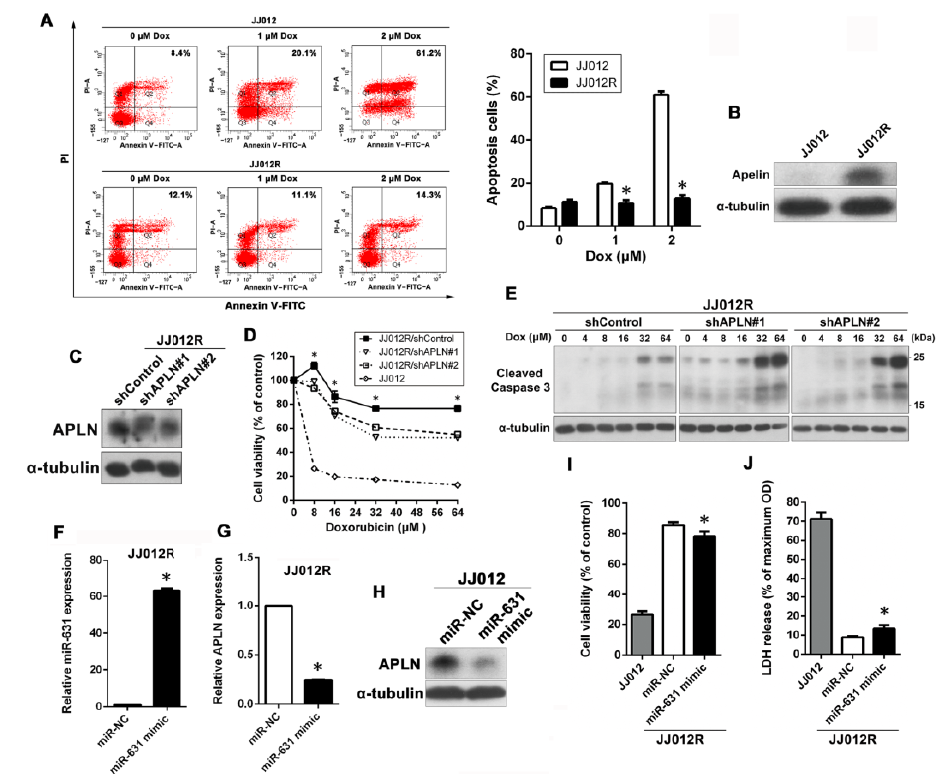
Figure 4. miR-631–APLN axis was also involved in Dox sensitivity in JJ012 cells. ( A ) Cells were exposed to increasing doses of Dox (0–2 µ M) for 24 h and apoptotic cells were analyzed by the annexin V-FITC/PI approach. * p < 0.05 compared with JJ012 cells. ( B ) The expression levels of APLN protein in total cell lysates between JJ012 and JJ012R cells were analyzed by Western blot. ( C ) The protein levels of APLN in JJ012R/shControl, JJ012R/shAPLN#1, and JJ012R/shAPLN#2 cells were examined using Western blot. ( D ) Cells were treated with increasing concentrations of Dox (0–64 µ M) for 24 h, and subsequently cytotoxicity was evaluated by an MTT assay. The percentage of cell viability is shown relative to untreated controls. * p < 0.05 compared with shControl group. ( E ) Cells were treated with increasing doses of Dox (0–64 µ M) for 24 h and the expression levels of cleaved caspase 3 were examined using Western blot. α -Tubulin was used as a loading control. ( F , G ) After the miR-631 mimic was delivered into JJ012R cells, the expression levels of miR-631 and APLN were further analyzed by qPCR. * p < 0.05 compared with miR-NC group. ( H ) The protein expression of APLN was analyzed by Western blot. ( I , J ) miR-631-transfected JJ012R cells and their parental cells (JJ012 cells) were treated with 8 µ M Dox for 24 h, and then the Dox susceptibility was determined by MTT and LDH assays, respectively. * p < 0.05 compared with miR-NC